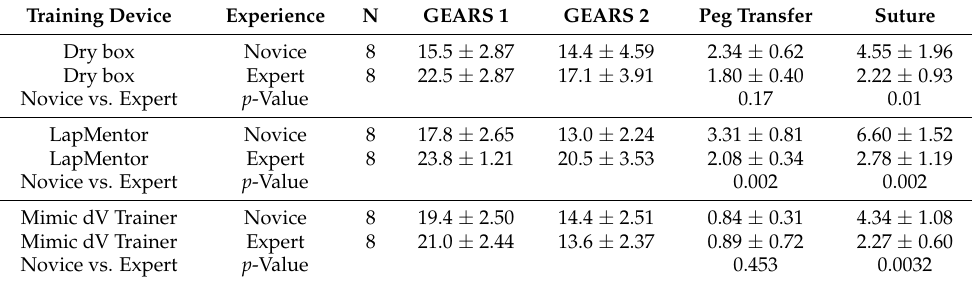
Table 2. Peg transfer and suture exercises performed using each simulator (day